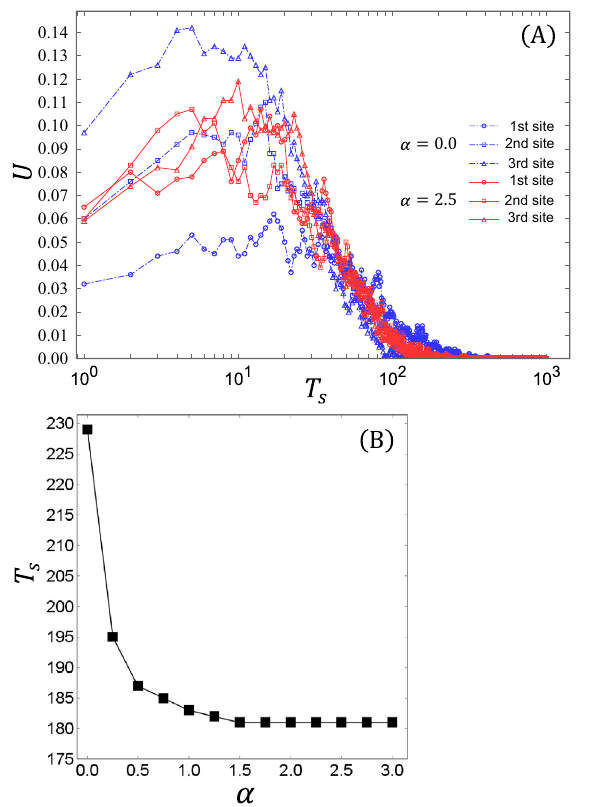
Figure 3. ( A ) Change of usage U of each node during the time taken for all agents to finish traveling to all the nodes, and ( B ) Dependence of the travel time for all agents visiting all the secondary nodes on the parameter α